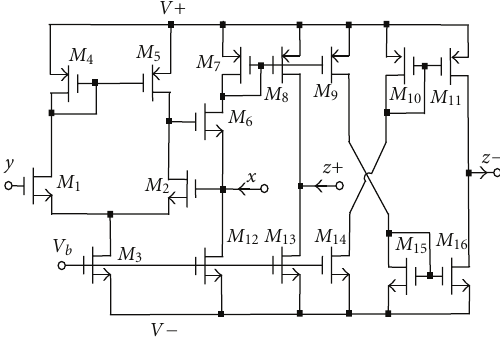
Figure 4: The CMOS MOCCII